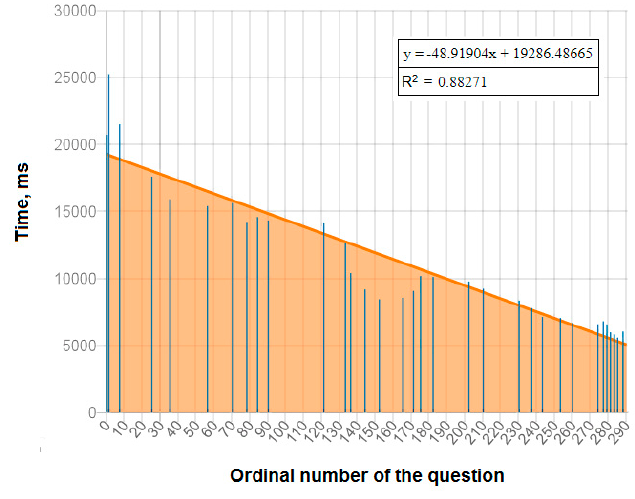
Figure 5. Linear regression model.